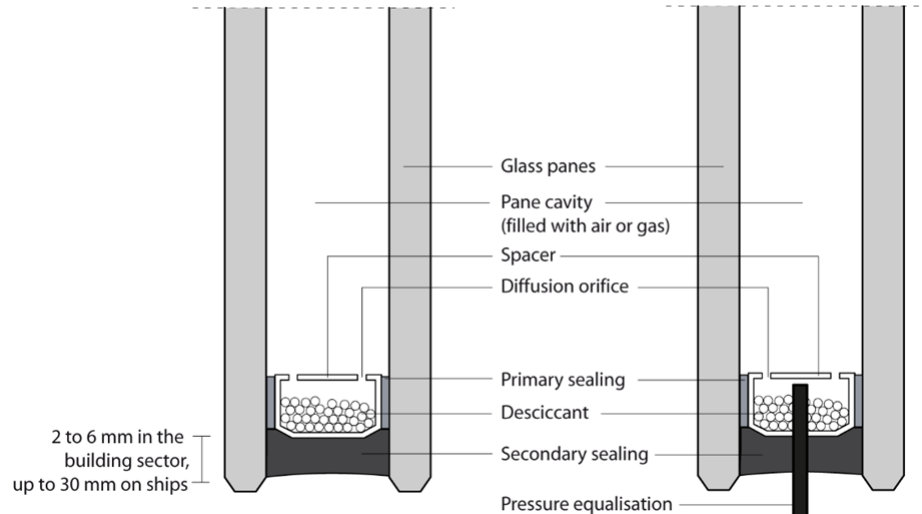
Fig. 1 Simplified illustration of insulating glass units without (specimen A – F) and with (specimen G) a pressure